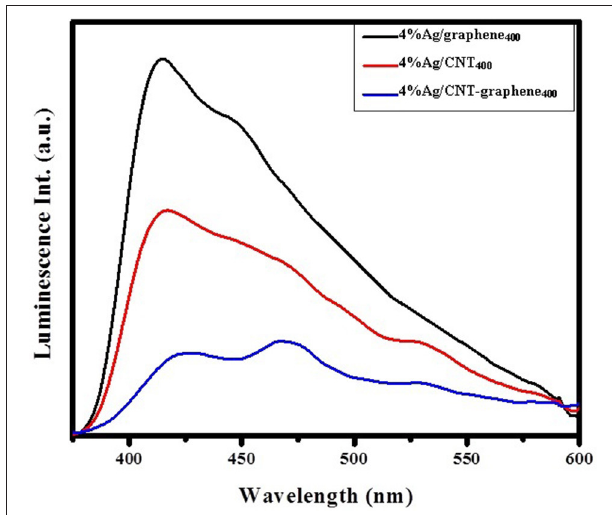
FIGURE 7 | Photoluminescence emission spectra of 4%Ag/graphene 400 , 4%Ag/CNT 400 , and 4%Ag/CNT-graphene 400 catalysts excited at